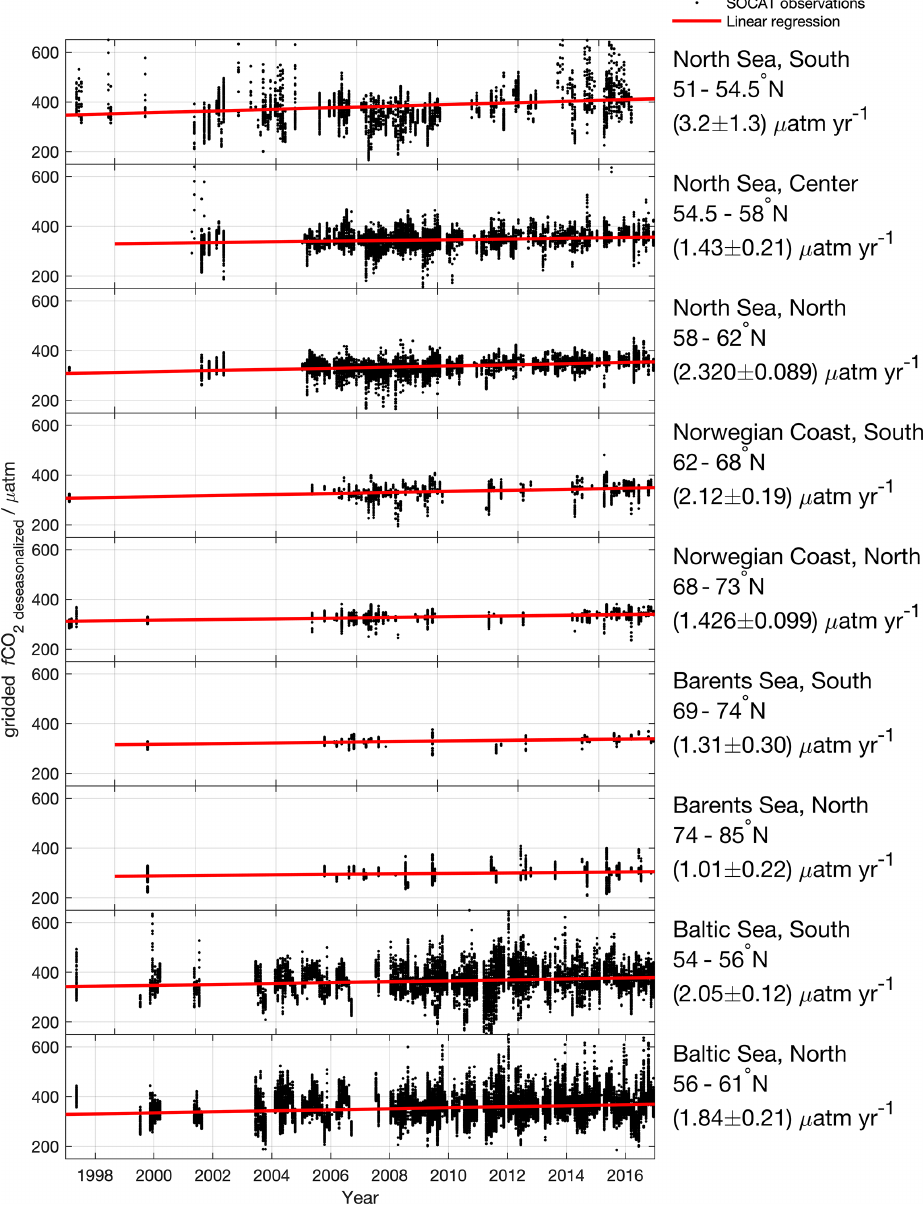
Figure A1. Trend in surface ocean f CO 2 in deseasonalized, gridded observation data (SOCAT v5).